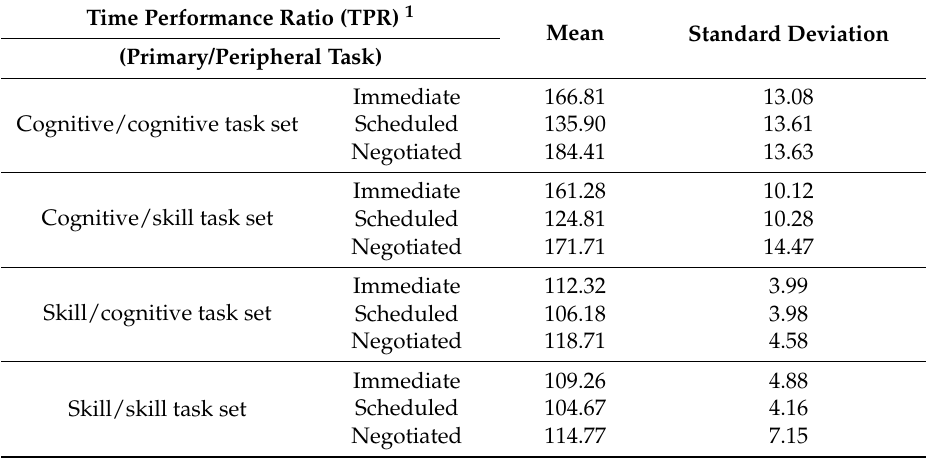
Table 5. Descriptive statistics of time performance ratio (TPR) under each task set.